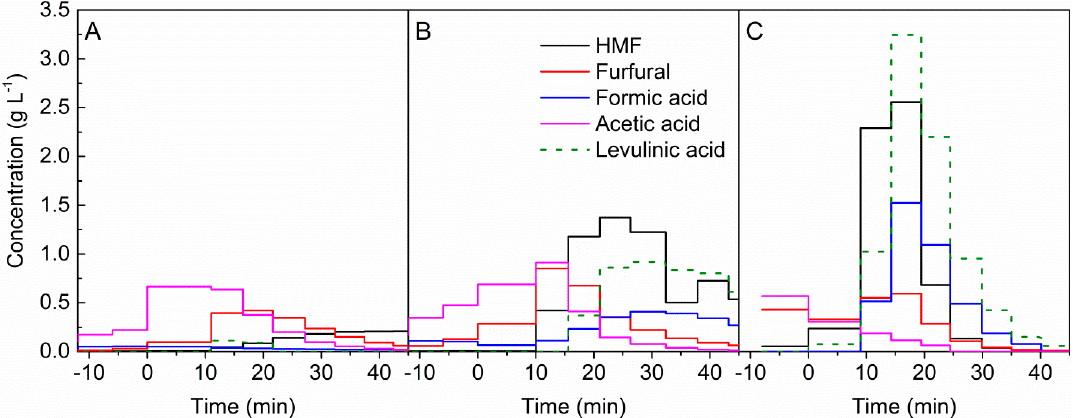
Figure 2. Formation of furfurals and organic acids during the hydrolysis of beech wood with 0.05 mol Figure2. Formationoffurfuralsandorganicacidsduringthehydrolysisofbeechwoodwith0.05molL − 1 L − 1 sulphuric acid at temperatures of ( A ) 180 °C, ( B ) 200 °C, and ( C ) 220 °C. t = 0 min marks the sulphuric acid at temperatures of ( A ) 180 ◦ C, ( B ) 200 ◦ C, and ( C ) 220 ◦ C. t = 0 min marks the beginning beginning of acid hydrolysis. HMF, hydroxymehtylfurfural. of acid hydrolysis. HMF,